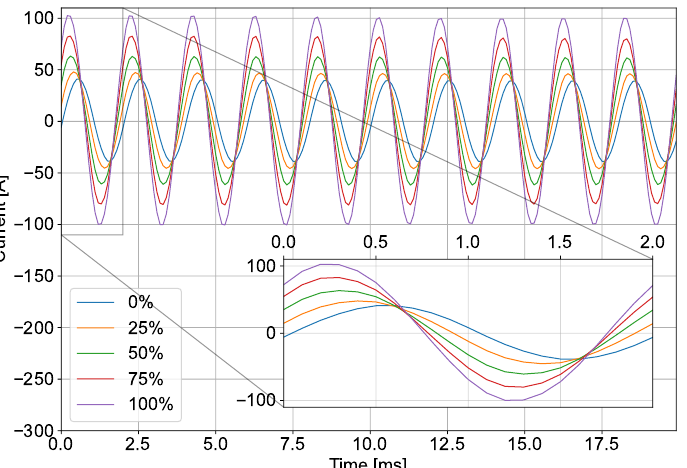
Figure 3. A 20 ms of phase A current in five simulated cases, where the load is approximately 0%, 25%, 50%, 75%, and